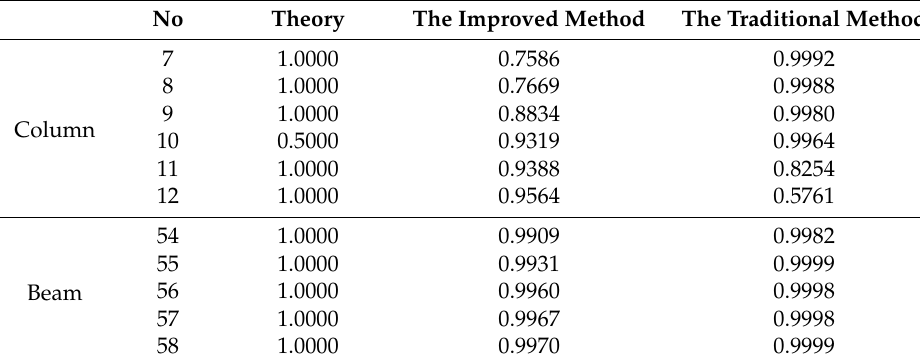
Table 7. Damage identification results with 11 damage factors of 2nd